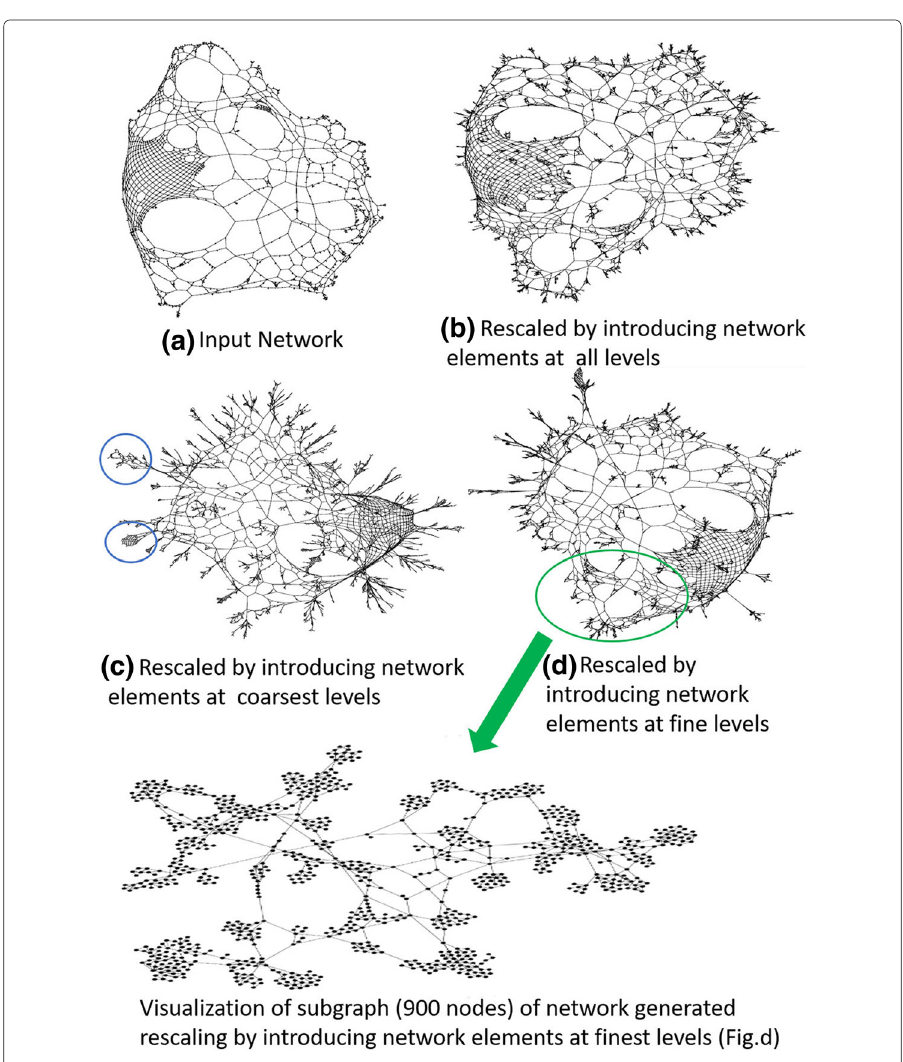
Fig. 16 Visualization of a road network from roadNet-TX with 2001 nodes and 2957 edges rescaled to at least 5900 nodes and 7000 edges. a Input network. b Rescaled by introducing network elements at all levels. c Rescaled by introducing network elements at coarsest levels. d Rescaled by introducing network elements at fine